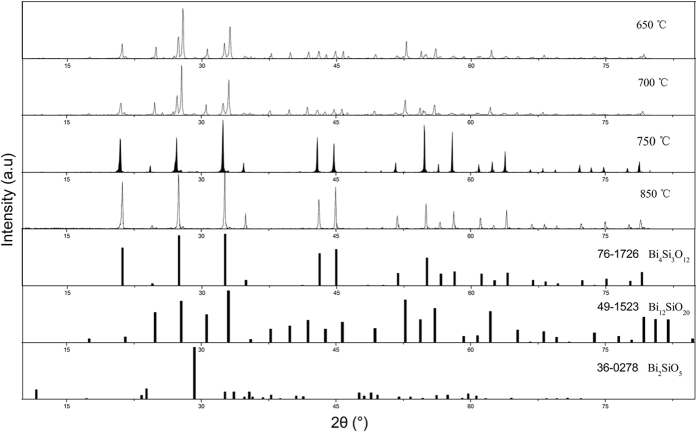
Powder X-ray diffractograms of microwave-prepared Bi4Si3O12: 2 at% Eu3+.